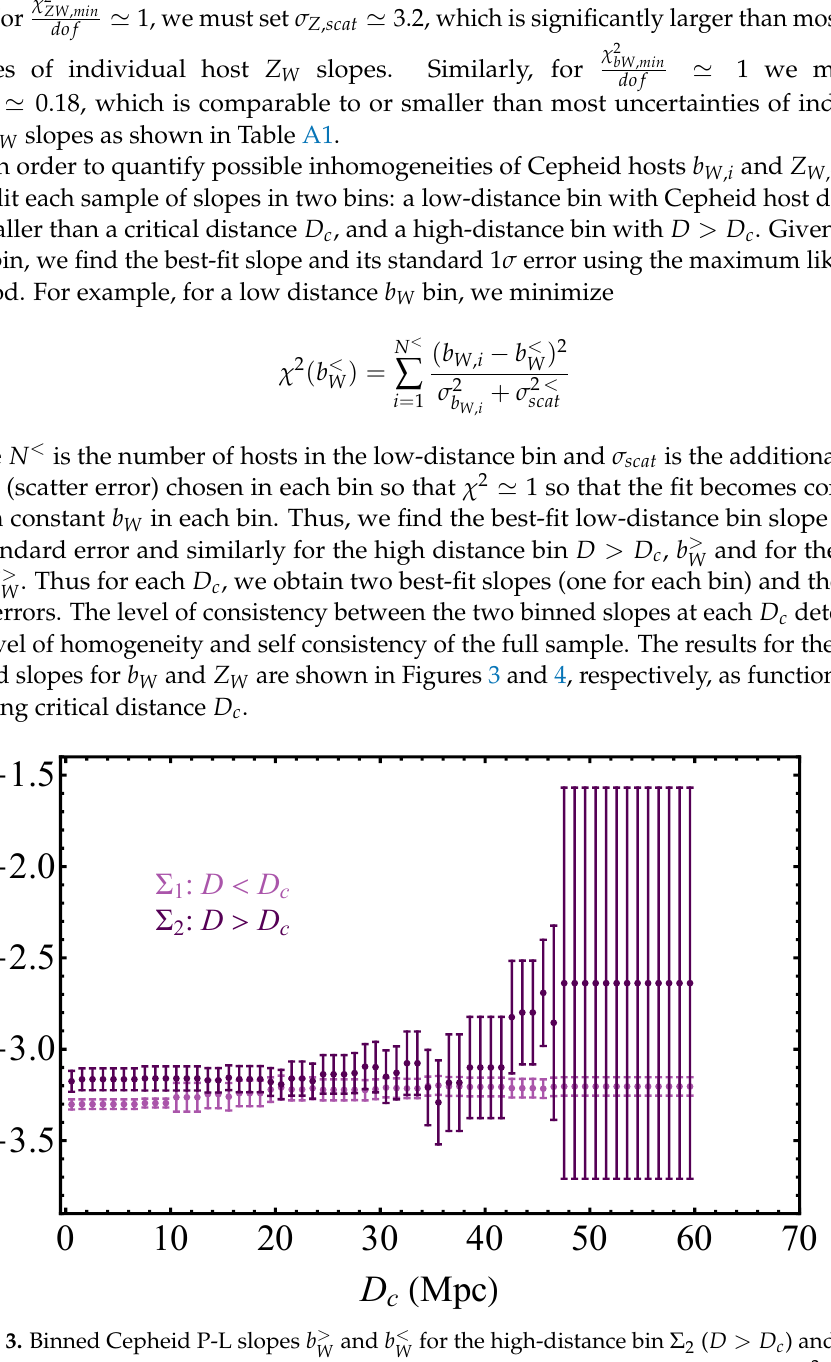
(cid:39) 1. bW , min